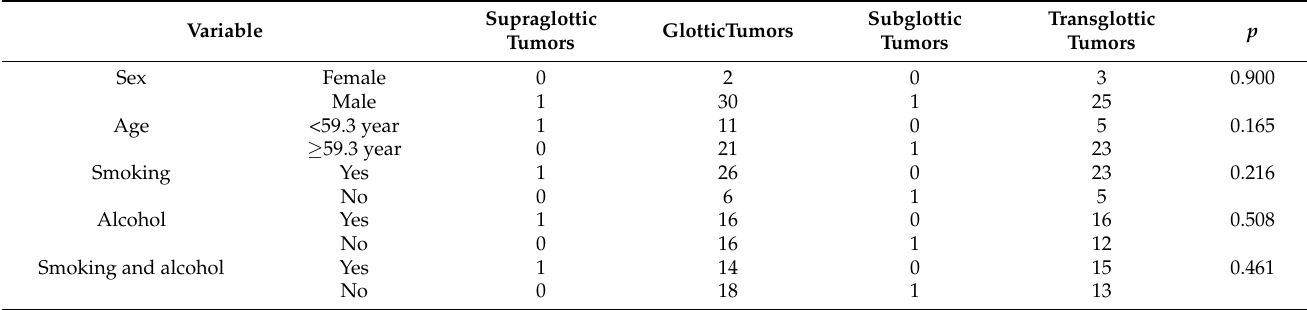
Table 1. Additional demographic characteristics of the LSCC